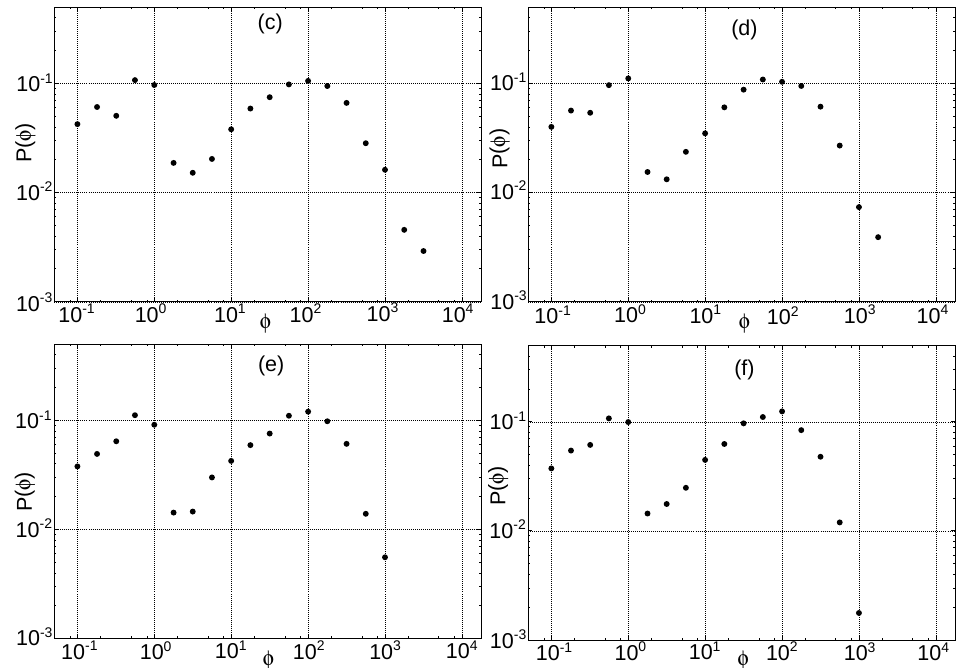
Figure 8. Distributions of the polarity intervals. The α -quenching by helicity ( γ = 0). ( a ) ν = 2.0; ( b ) ν = 2.2; ( c ) ν = 2.3; ( d ) ν = 2.6; ( e ) ν = 2.8; ( f ) ν = 3.3.